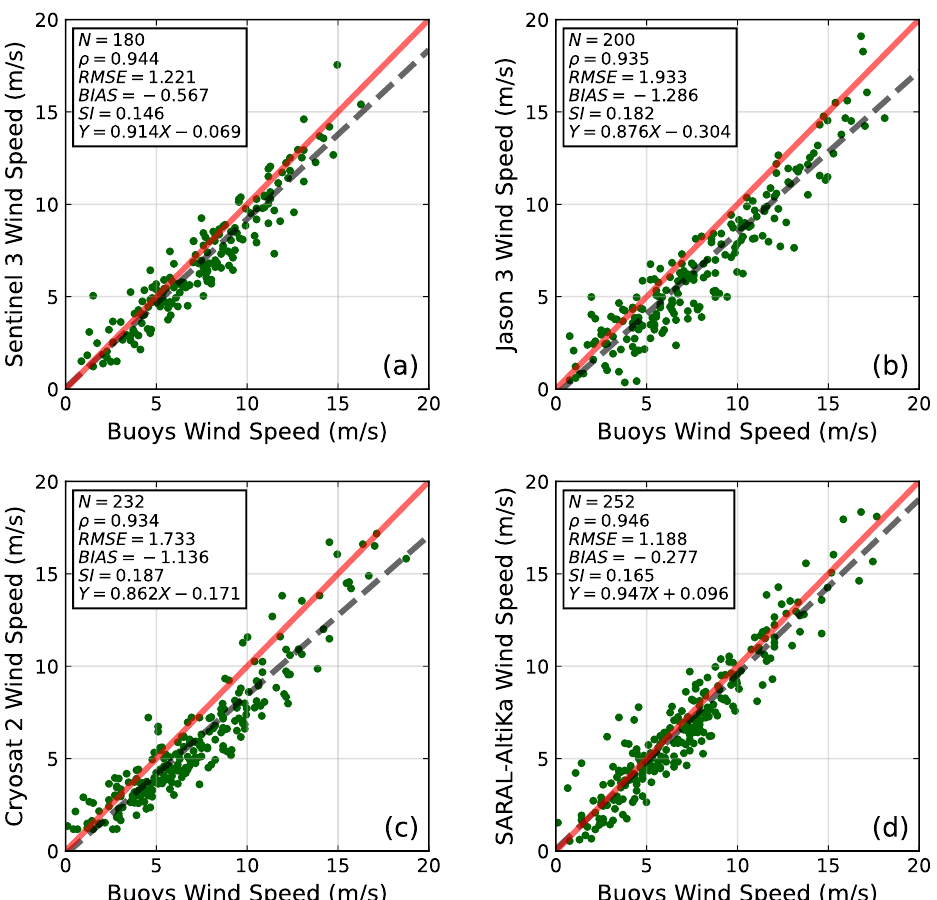
Figure A2. WS validation of ( a ) Sentinel 3, ( b ) Jason 3, ( c ) Cryosat 2 and ( d ) SARAL-AltiKa against observations from the buoys in the Northeast, after being adjusted to 10 m height, assuming neutral stability. N is the collocated dataset sample size and ρ is Pearson’s correlation coefficient. The dashed grey line represents the theoretical Y = X line assuming the two types of measurements are identical. The red line represents the OLS linear regression fit using X and Y to represent the collocated buoy and altimeter